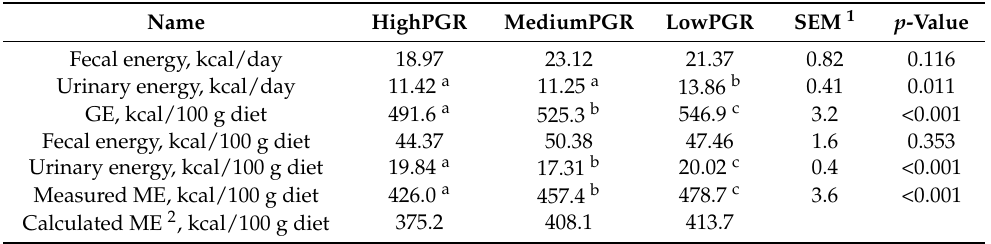
Table 4. Intake and excretion (as is basis and per 100 g) of energy of cats of 3 experimental diets differing in perceived glycemic response